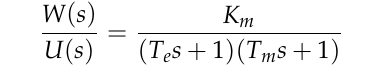
Figure 4. Schematic diagram of the 1-DOF visual sensor stabilization platform in the shark-like robotic fish.